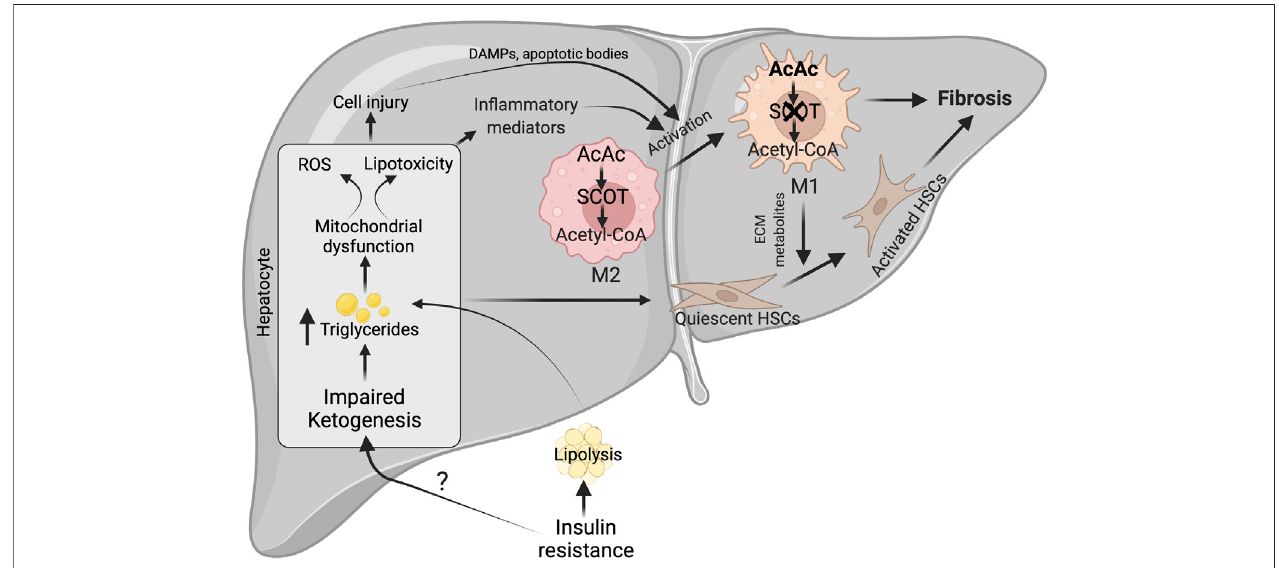
FIGURE 4 | Possible mechanisms for impairment of hepatic ketogenesis and its contribution to NASH and fi brosis. Under NASH, insulin resistance was the major contributing factor for the impairment of hepatic ketogenesis. This impairment in hepatic ketogenesis can promote lipotoxicity, mitochondrial dysfunction and ROS generation in the hepatocytes. Finally, all these results in NASH progression by activating cell injury and in fl ammation. In addition, the impairment in hepatic ketogenesis can promote fi brosis through the various factors derived from the injured hepatocytes and activation of macrophages. The activation of macrophages takes place when there is an impairment in the oxidation of AcAc, resulting in the accumulation of acetyl CoA. This results in conversion of M2 macrophage phenotype to M1, which are pro-in fl ammatory in nature. ROS-reactive oxygen species, AcAc-acetoacetate, SCOT-succinyl-CoA-oxoacid transferase, ECM-extracellular matrix.